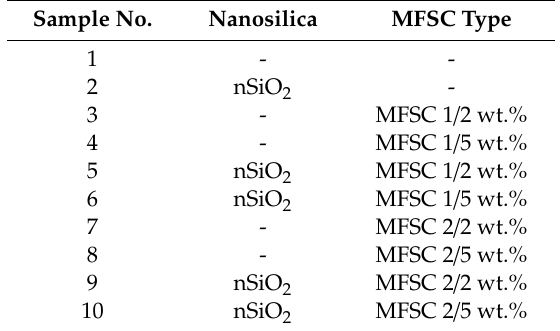
MFSC: multi-functionalized organosilicon